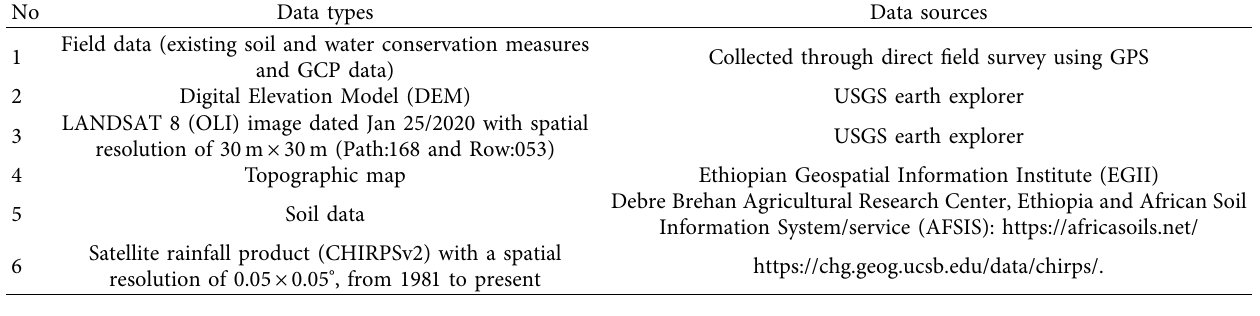
Table 1: Types of data used and its source.